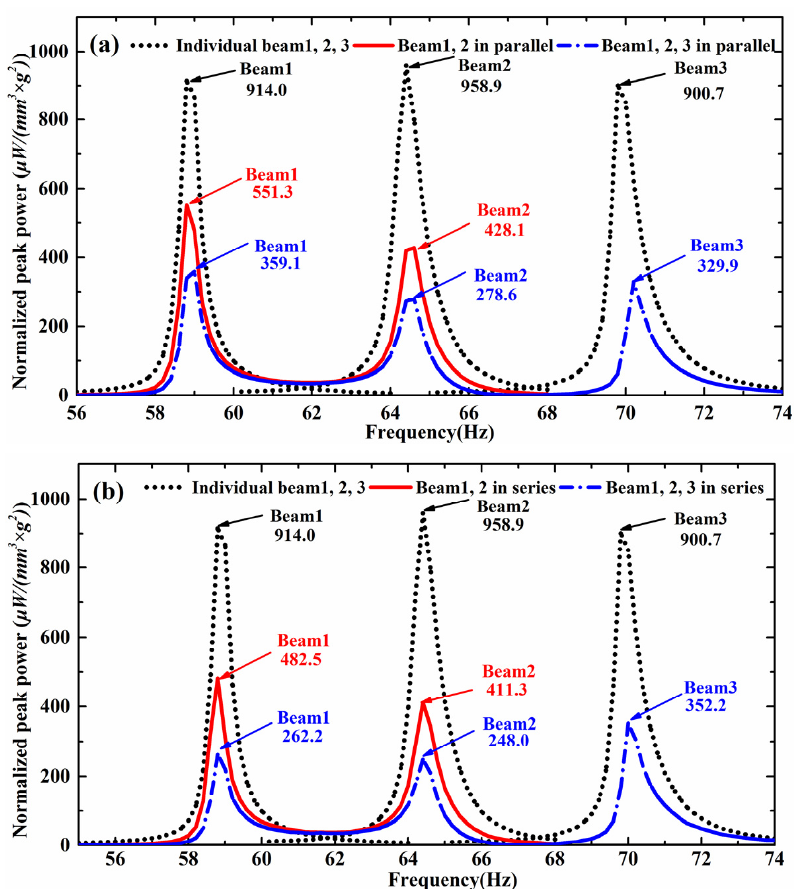
Figure 6. Normalized output power of AB ‐ VEH connected in ( a ) parallel and ( b ) series with optimal load resistance.